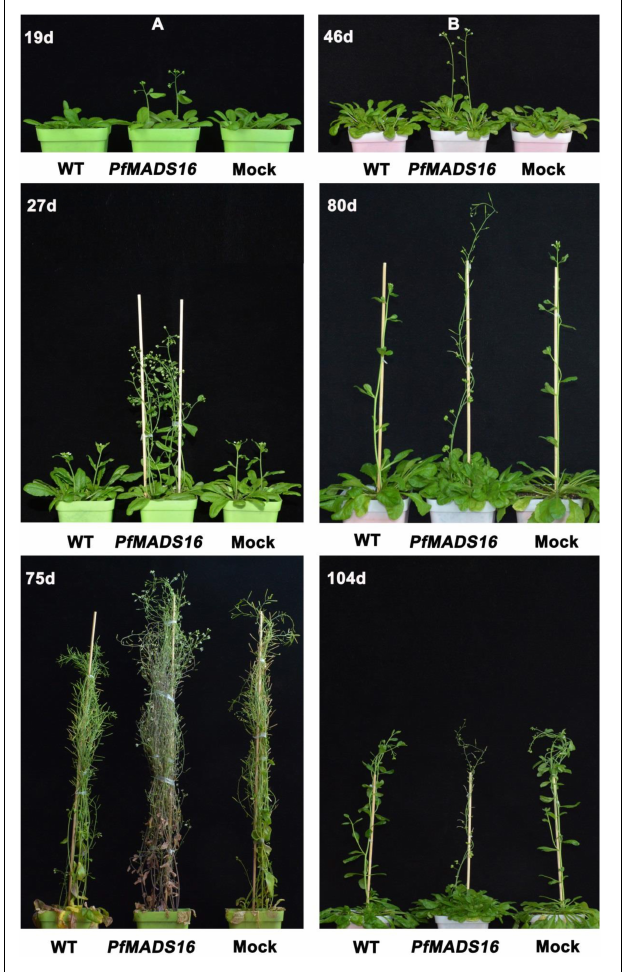
FIGURE 1 | Flowering phenotypes of representative PfMADS16 transgenic Arabidopsis thaliana plants under long day (LD) (A) and short day (SD) conditions (B) in comparison to untransformed WT and Mock transgenic plants. Photos were taken 19, 27, and 75 days after transplanting under the LD conditions, and 46, 80, and 104 days after transplanting under SD conditions.